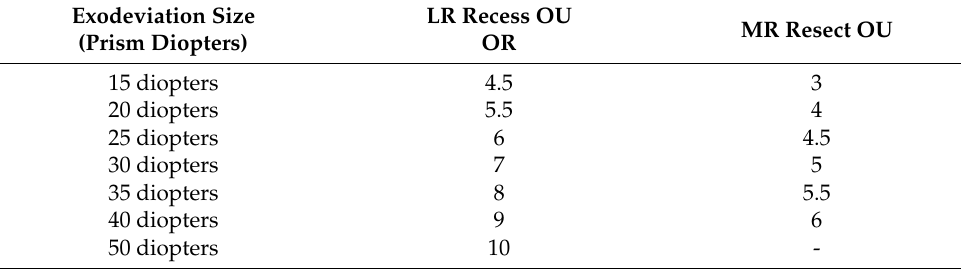
Table 2. Surgical table for symmetrical two muscle